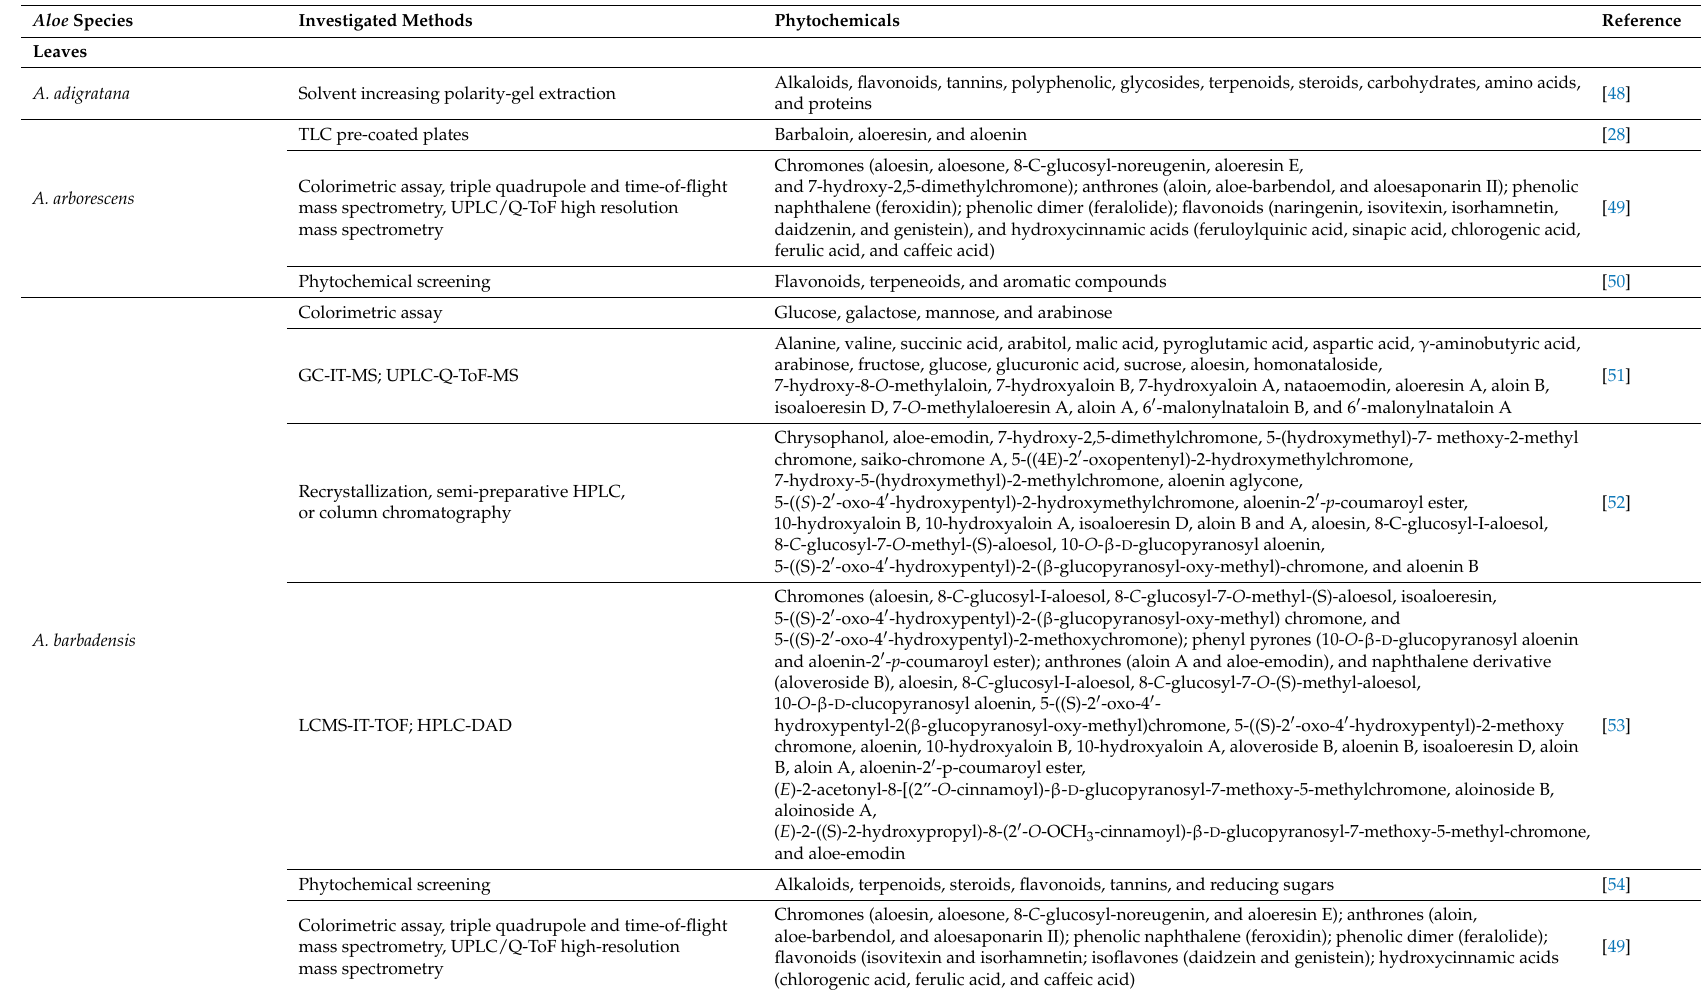
Table 4. Phytoconstituents of Aloe species extracted with different